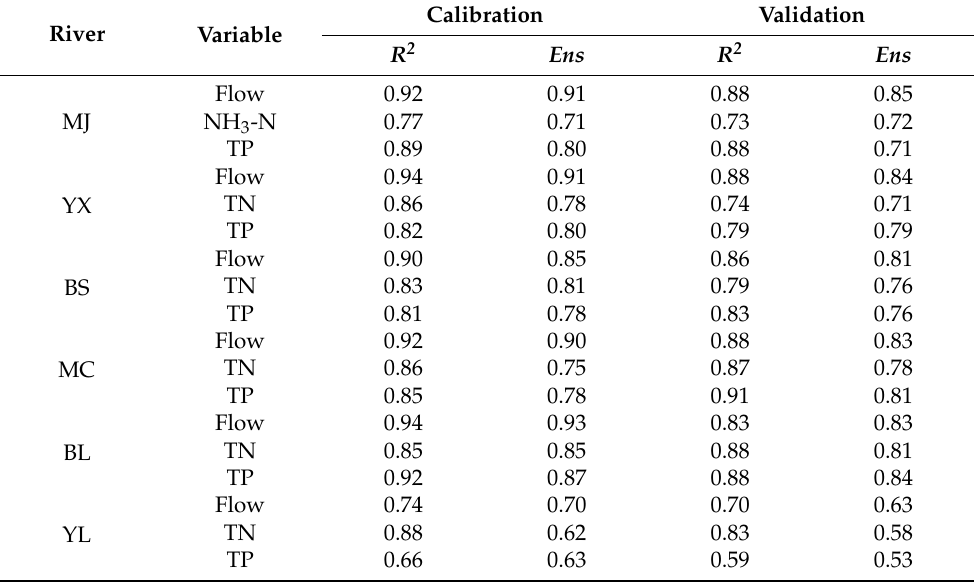
Table 4. Calibration and validation of SWAT model simulation parameters in sub-watersheds.